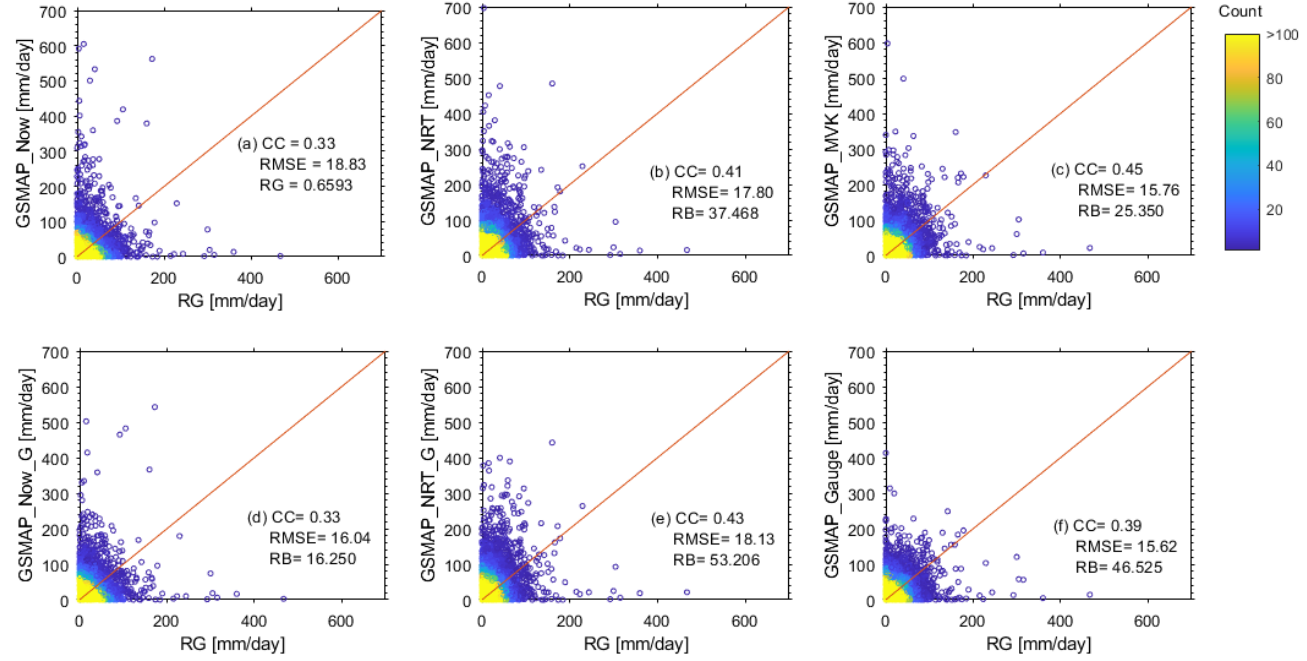
Figure 7. Scatterplot for daily data of GSMaP_Now (a), GSMaP_NRT (b), GSMaP_MVK (c),